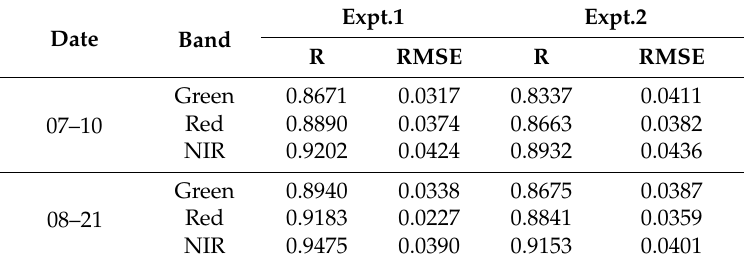
Table 5. Accuracy assessment of Expt.1 and Expt.2.